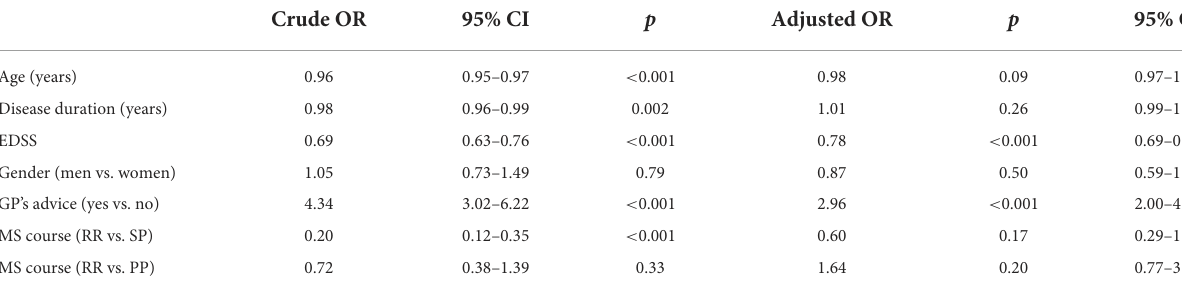
TABLE 3 Logistic regression model considering different covariates as predictors of exercise